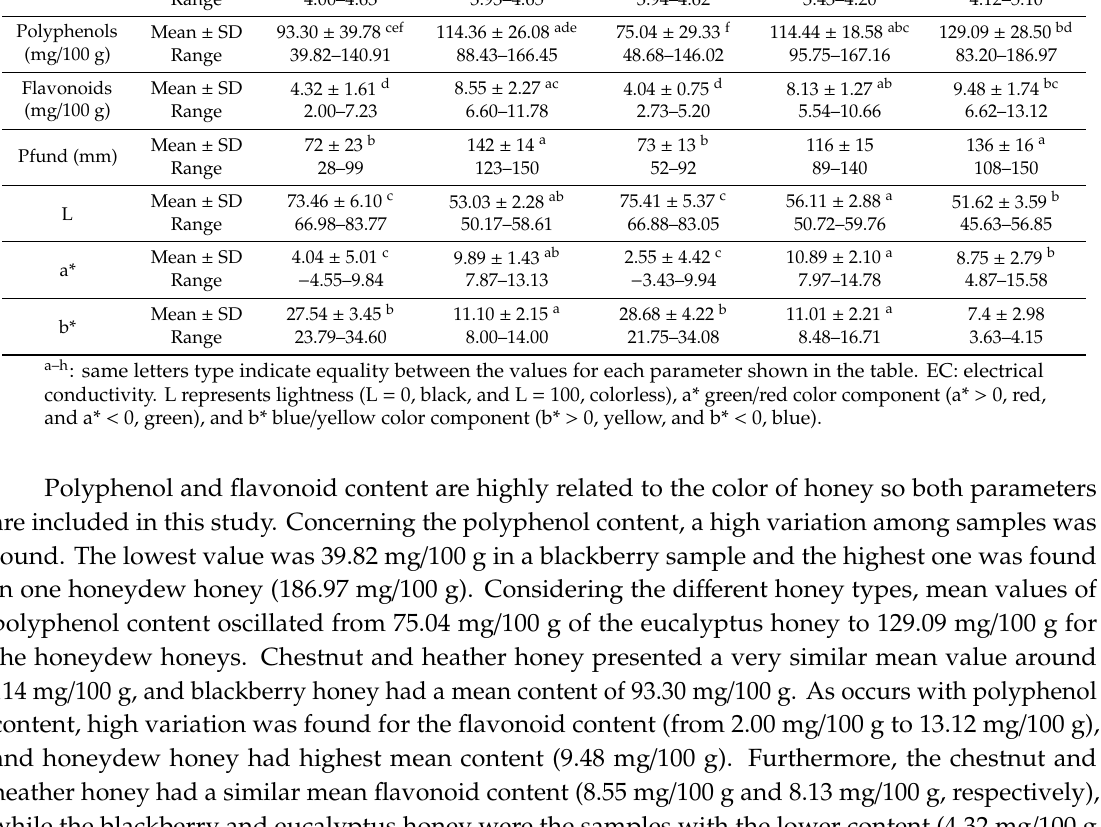
Table 2. Physicochemical characteristics by honey type.